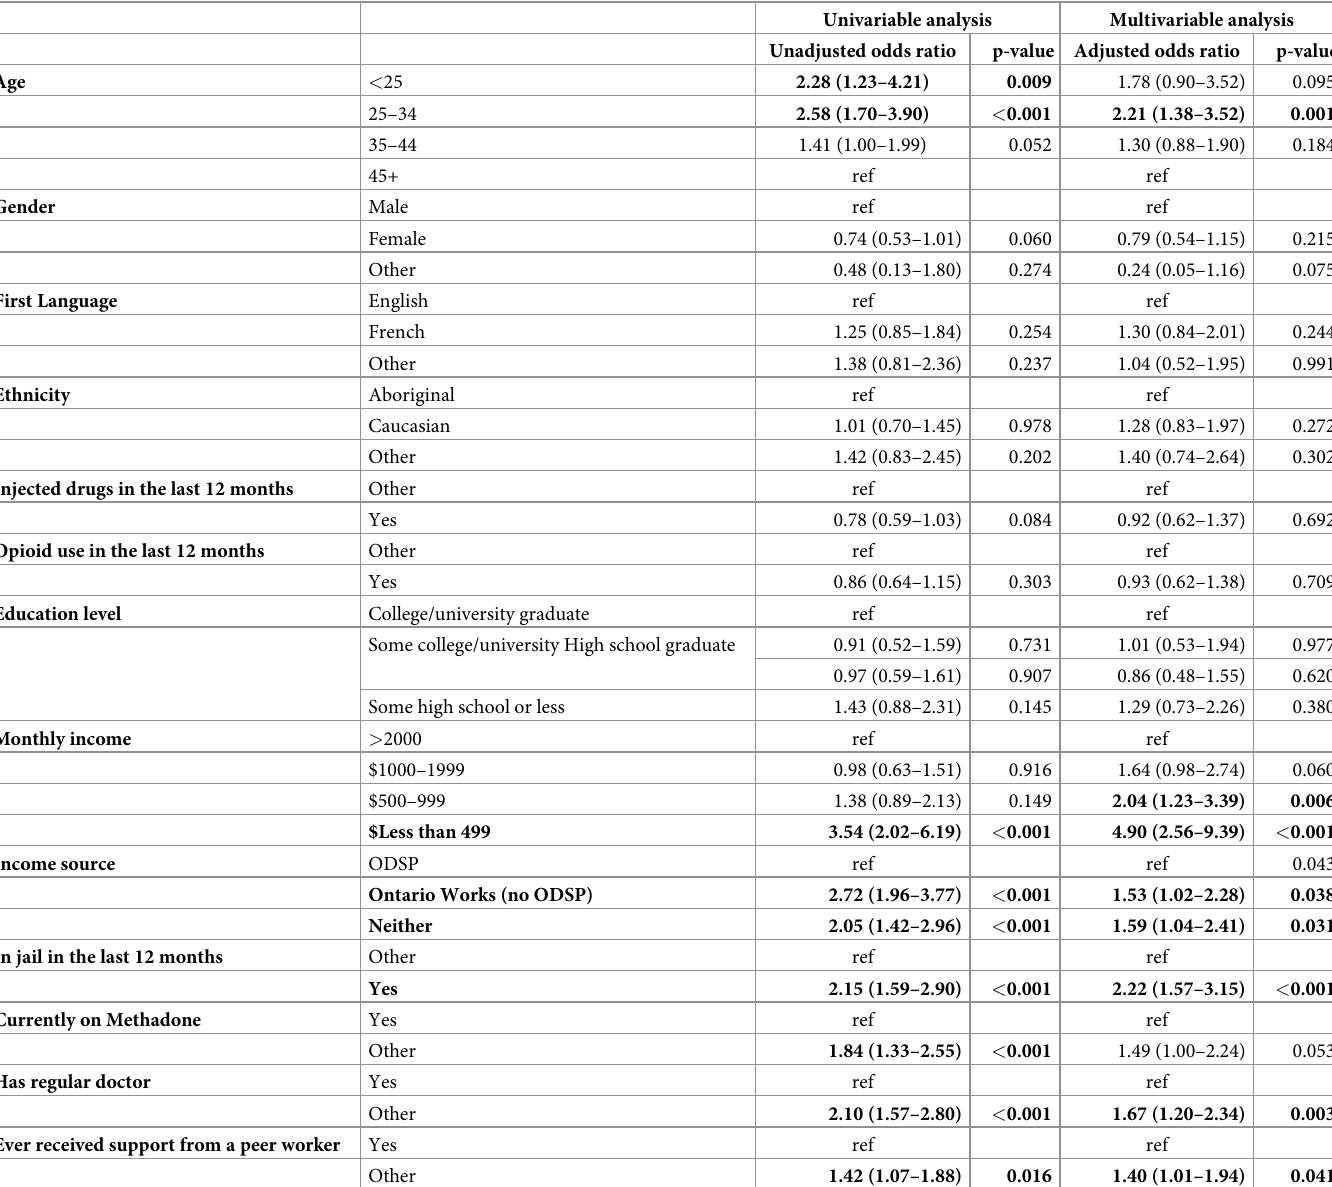
Table 2. Unadjusted and adjusted analysis of characteristics associated with unstable housing, adjusted for listed characteristics (n =